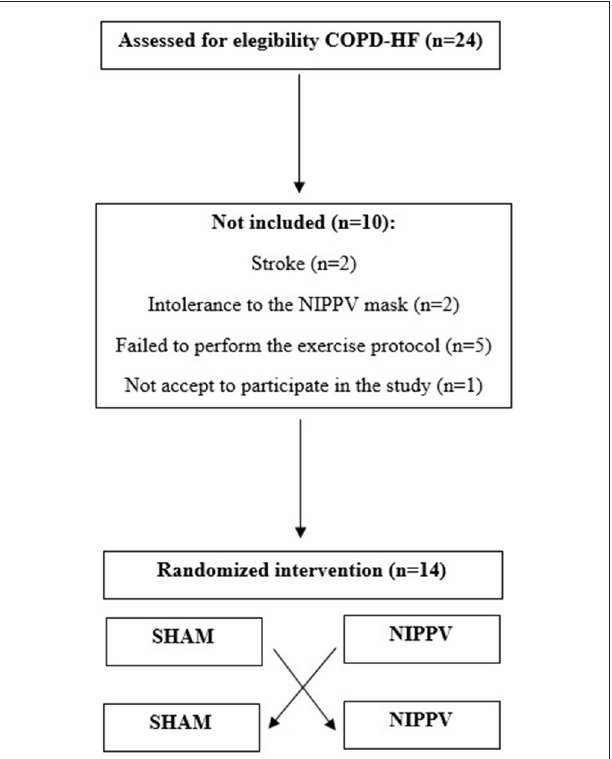
FIGURE 2 | Flow diagram representing the sample recruitment and